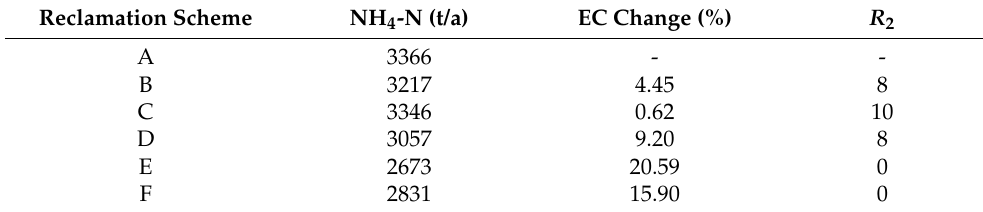
Table 20. Feasibility evaluation of NH 4 -N environmental capacity.